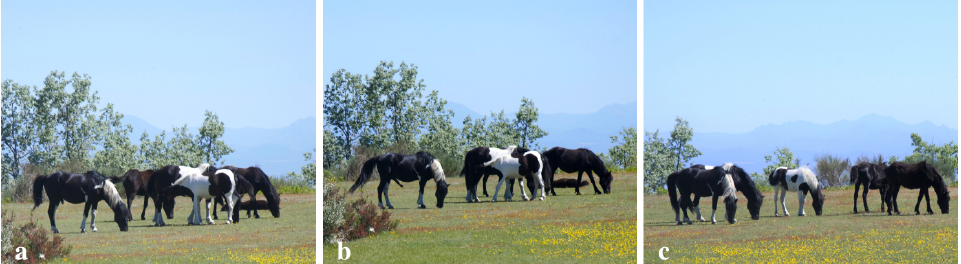
Figure 3. Stallion (left) performing ingestive behavior: ( a ) before E/M bout; ( b ) during E/M bout; and ( c ) after E/M